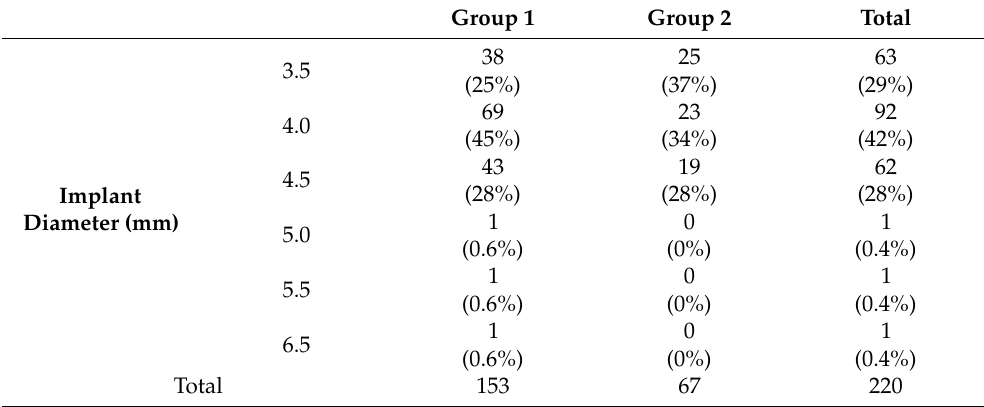
Table 2. Frequency of implant diameter in Group 1 (EA ≥ 30 ◦ ) and Group 2 (EA < 30 ◦ ).